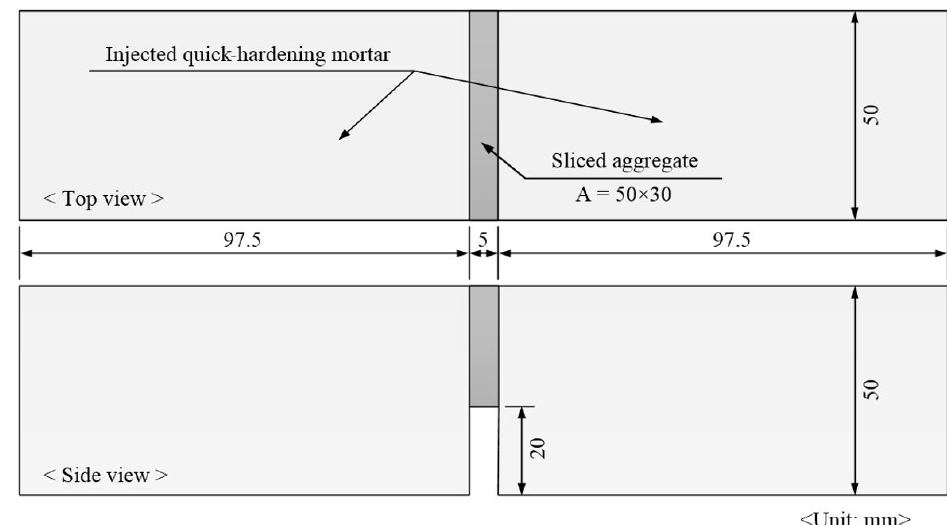
Figure 2. Geometry of the interfacial fracture toughness (IFT) specimens [4].